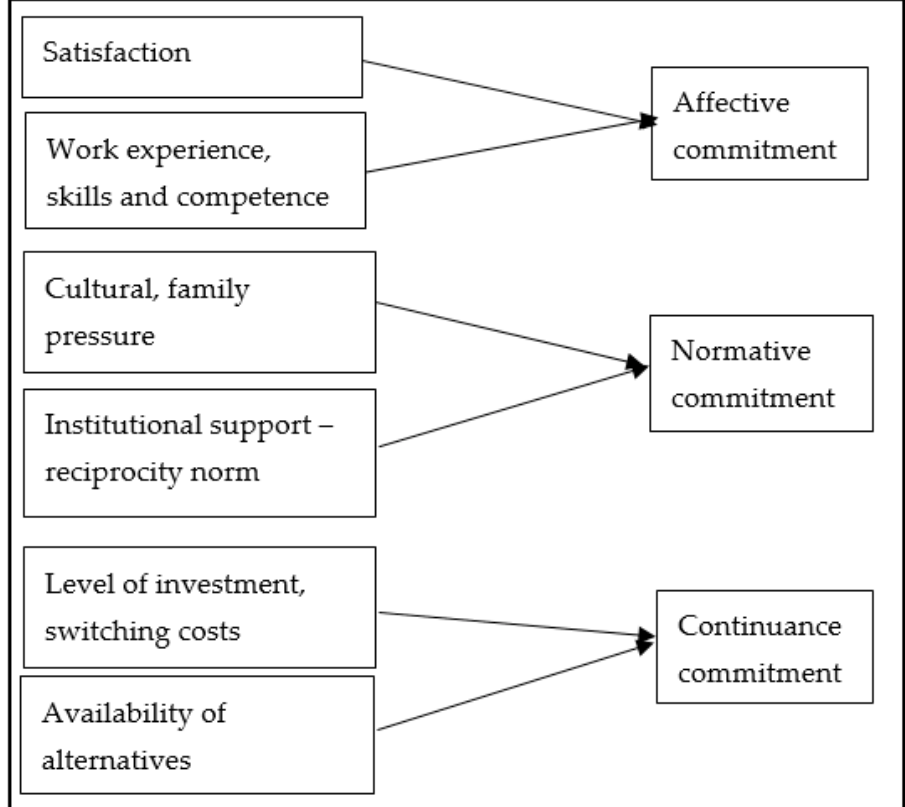
Figure 10. Variables affecting commitment to an existing practice or technology. Based on Meyer and Allen [16].